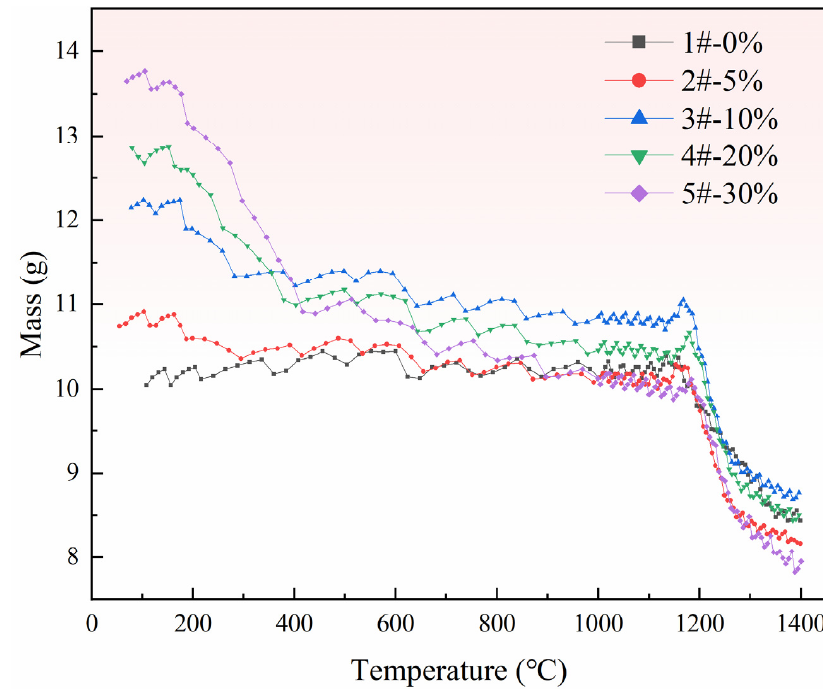
Figure 6. Mass change of pellets during heating.